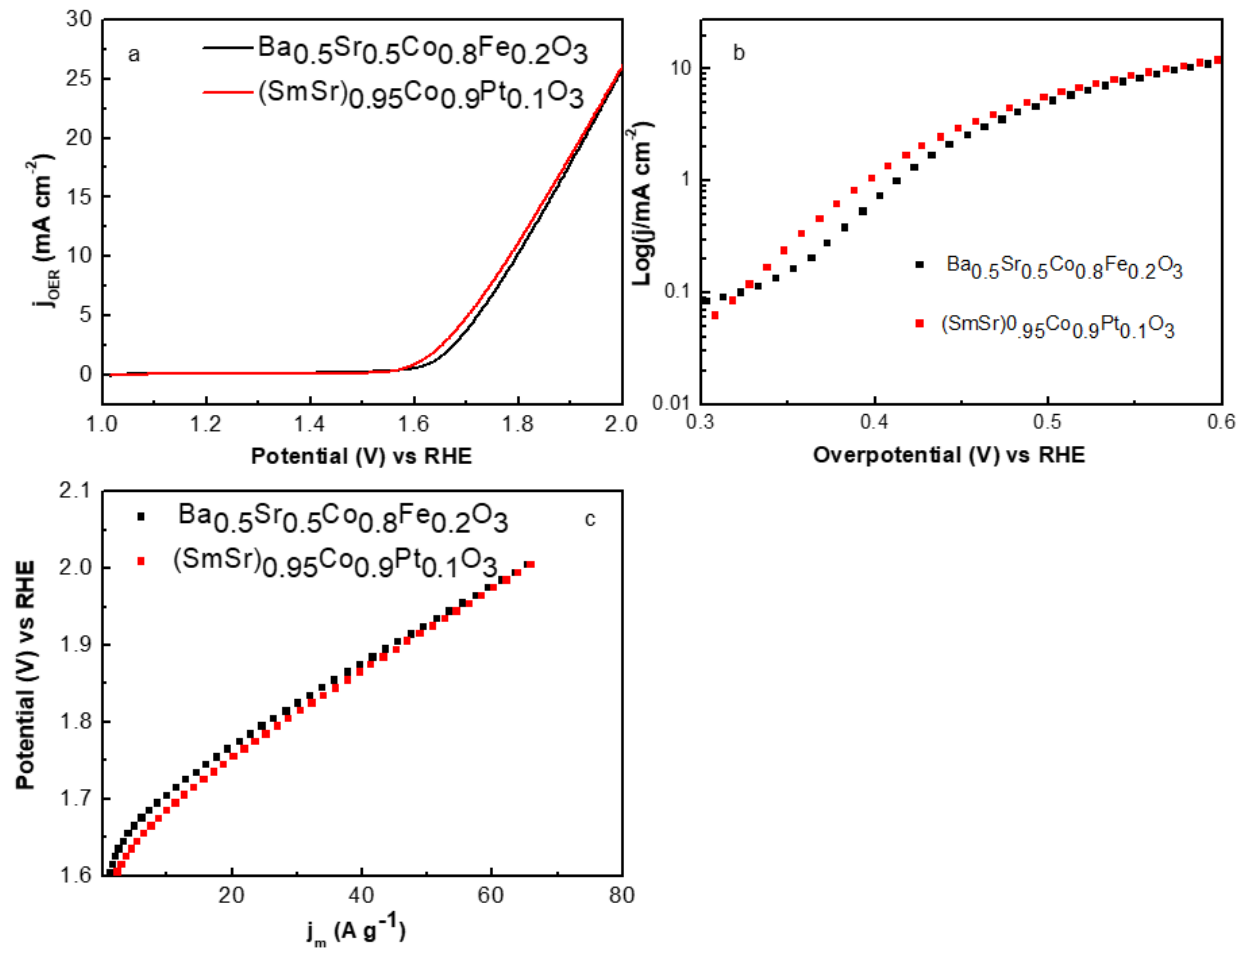
Figure 5. ( a ) LSV curves of (SmSr) 0.95 Co 0.9 Pt 0.1 O 3 , Ba 0.5 S r0.5 Co 0.8 Fe 0.2 O 3 catalysts for OER at 5 mV s −1 scan rate. ( b ) Tafel plots and corresponding fitted slopes at 1 mV s −1 . ( c ) MA comparison.